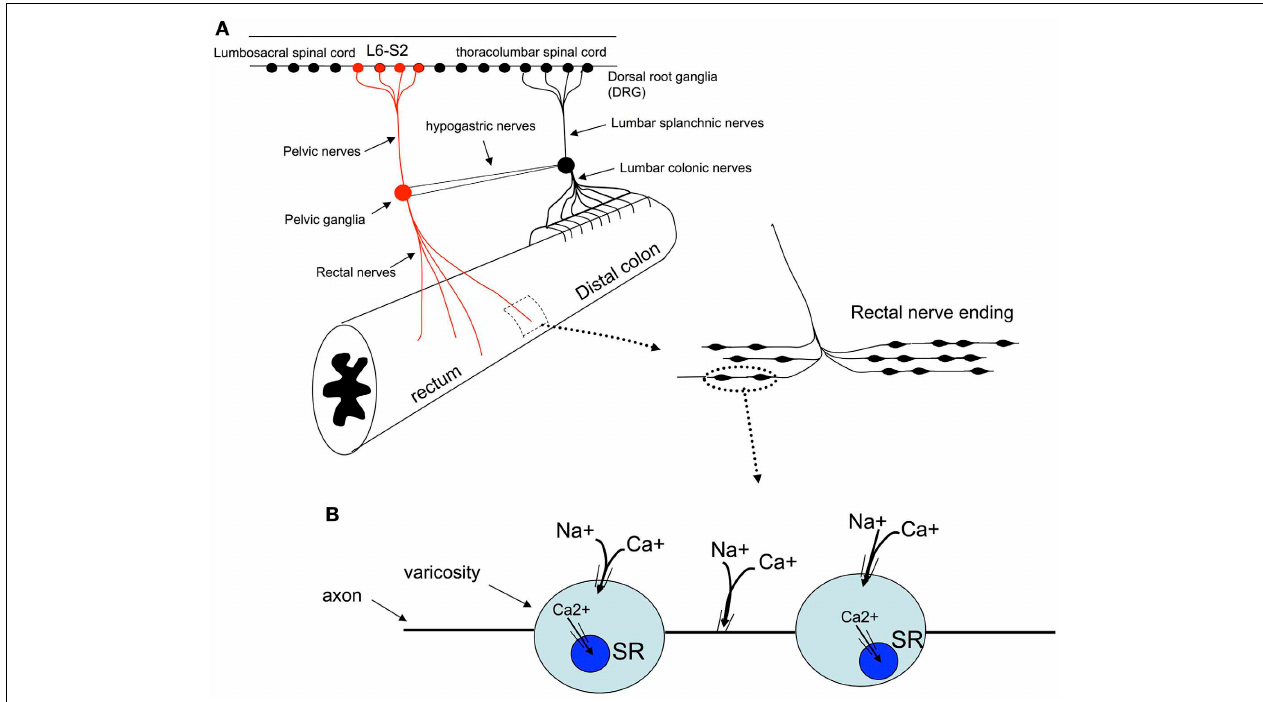
FIGURE 9 | Schematic representation of the proposed mechanisms by which colonic circumferential stretch activates synchronized calcium transients in rectal afferent nerve terminals. (A) Shows the primary pain pathway from the mouse colorectum, see (Kyloh et al., 2011). (B) It is suggested that circumferential stretch of these nerve endings leads to the opening of non-selective cationic channels which